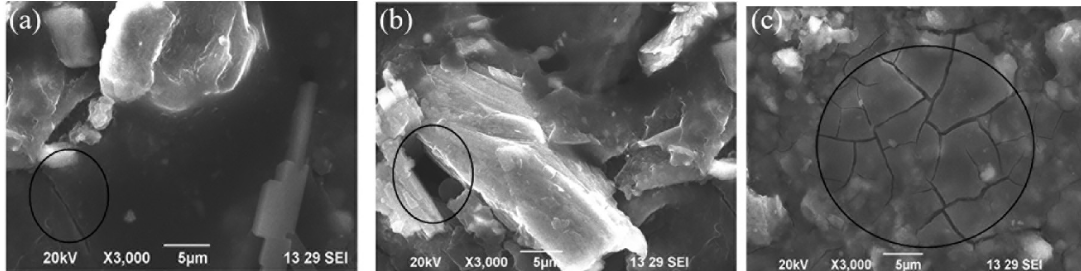
Figure 8: Fracture morphology of Al 7020 FSW joint with Zn interlayer (SEM). (a)Cleavage fracture (b) void growth induced by cavitations/debonding. (c) Crack due to metal deposition. Table 5: Tensile test results of Al7020 alloy joints with Zn interlayer. Inter-Layer Thickness